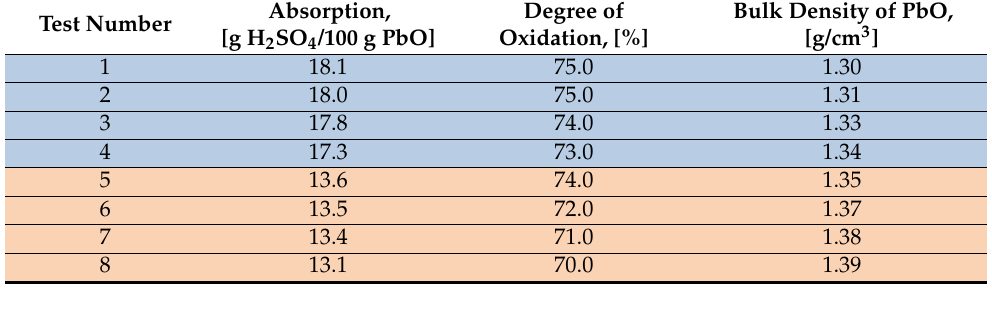
Table 4. Properties of the obtained product (blue color—high humidity; brown color—low humidi- ty).